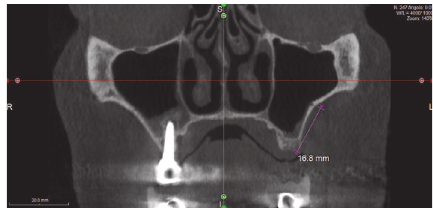
Figure 5: CBCT of the sinuses. The maxillary intraosseous anasto- mosis at the left sinus is 16.8 mm above the ridge coronal bone level.